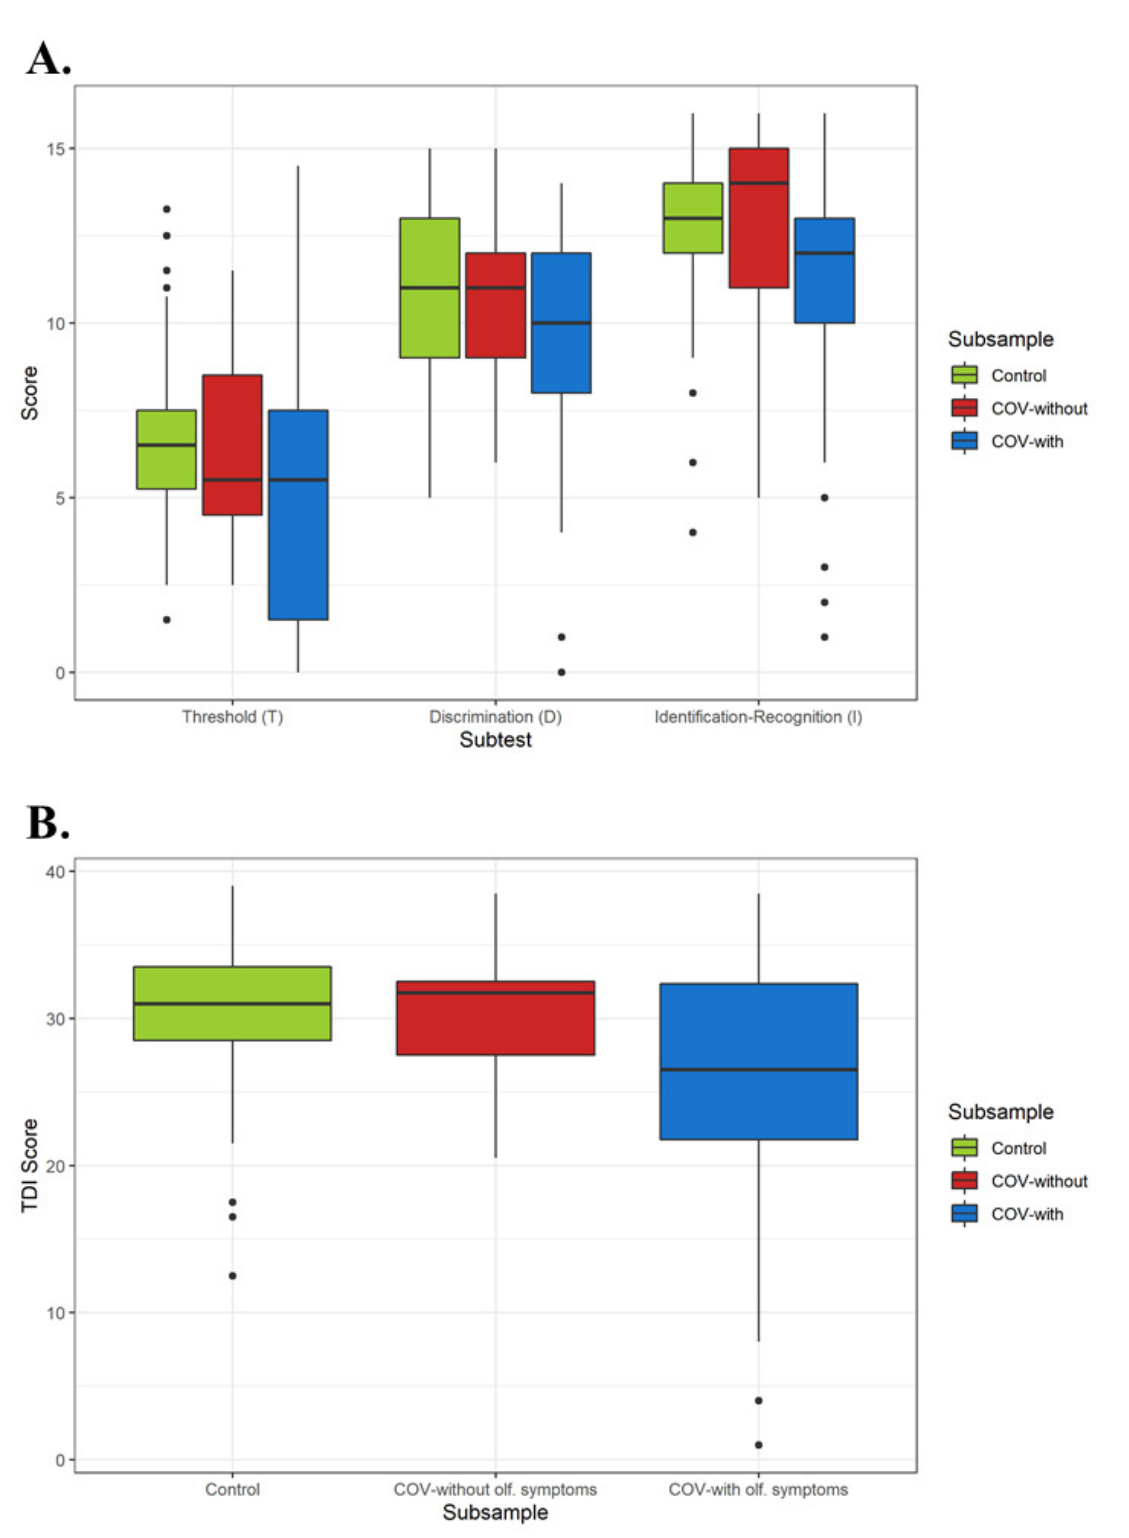
Figure 1. Boxplots by COVID-19 subsample and control group for: ( A ) T, D, and I scores (I-Recognition) and ( B ) TDI score.